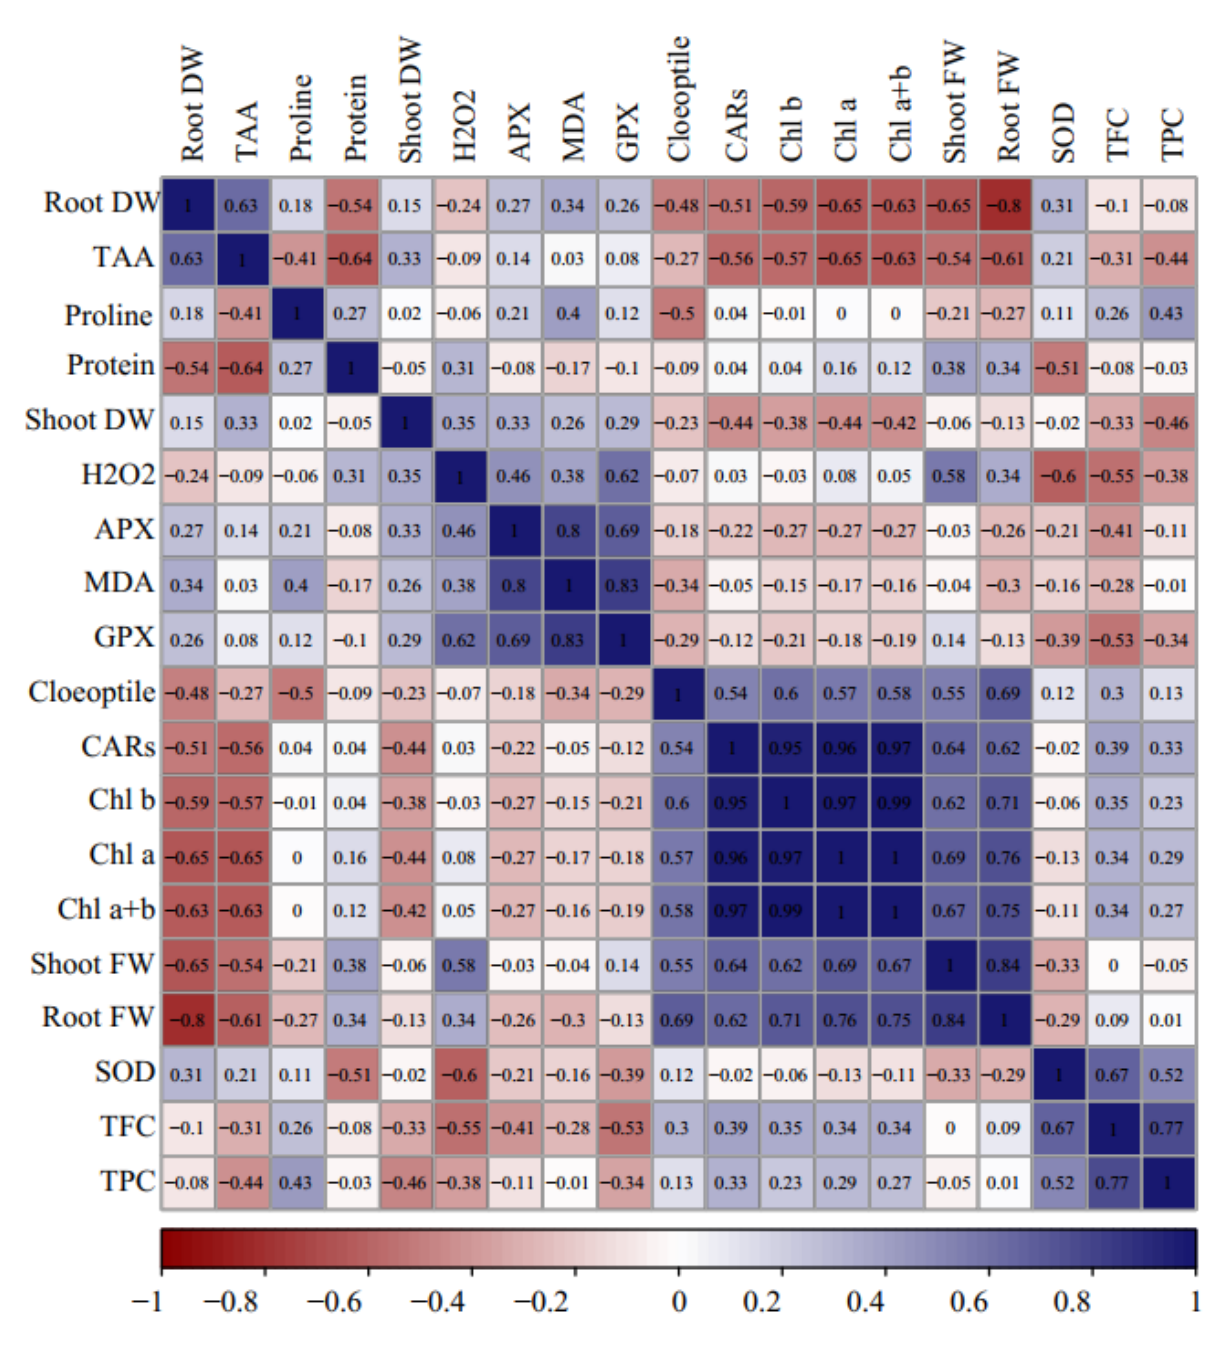
Figure 4. Heat map of Pearson’s correlation analysis for the response of Cucumis melo genotypes to the sorbitol and PEG-induced drought stress under in vitro conditions. Heat map representing coleoptile length, shoot and root FW and DW, chlorophyll a (Chl a), chlorophyll b (Chl b), total chlorophyll (Total Chl), carotenoids (CARs), proline content, malondialdehyde (MDA), H 2 O 2 content, total soluble protein content, guaiacol peroxidase (GPX) activity, ascorbate peroxidase (APX) activity, superoxide dismutase (SOD) activity, total flavonoids content (TFC), and total phenol content (TPC).